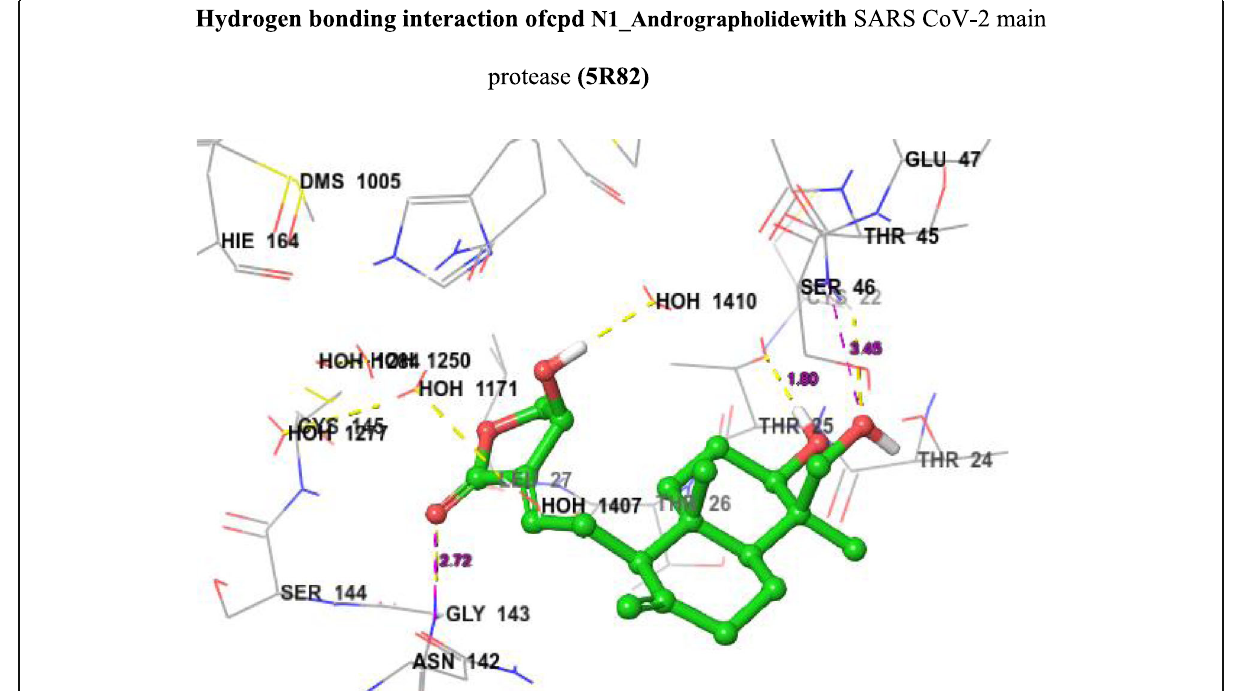
Fig. 5 Hydrogen bonding interaction of cpd N1_Andrographolide with SARS CoV-2 main protease (5R82)